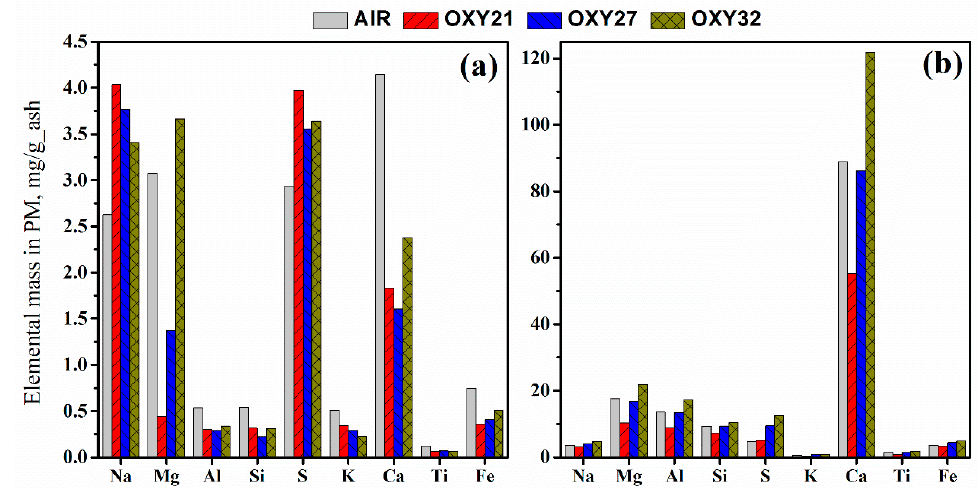
Figure 7. Absolute mass of inorganic elements in ( a ) PM 0.5 and ( b ) PM 0.5–10 during air and oxy-fuel combustion.